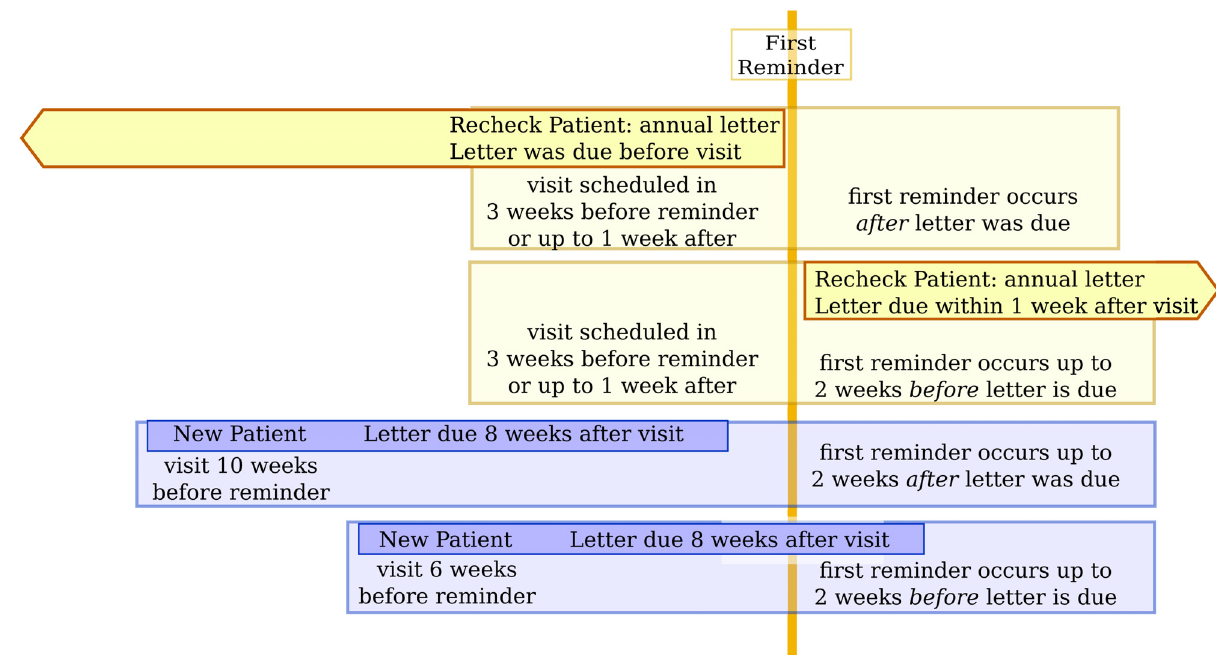
Fig 1. Range of possible relationships between the patient visit, the letter due date, and the first reminder. Recheckpatients should get a letter every year (or 2 years for internalmedicine). If a recheck patient had a visit duringthe trial, they were eligiblefor a reminder if the letter was due before the visit (sometimes, long before the start of the trial) or up to 1 week after the visit. Reminderswere sent for appointments that had alreadyoccurred and appointments scheduledfor the coming week, meaningthat reminderswere sent no more than 2 weeks before the letter was due. New patients should get a letter within 8 weeks of their visit. Patients were considered eligiblefor a reminderif they did not yet have a letter at 6 weeks after their visit, meaningthat the first reminderfor a patient was issued 6 to 10 weeks (an averageof 8 weeks) after the